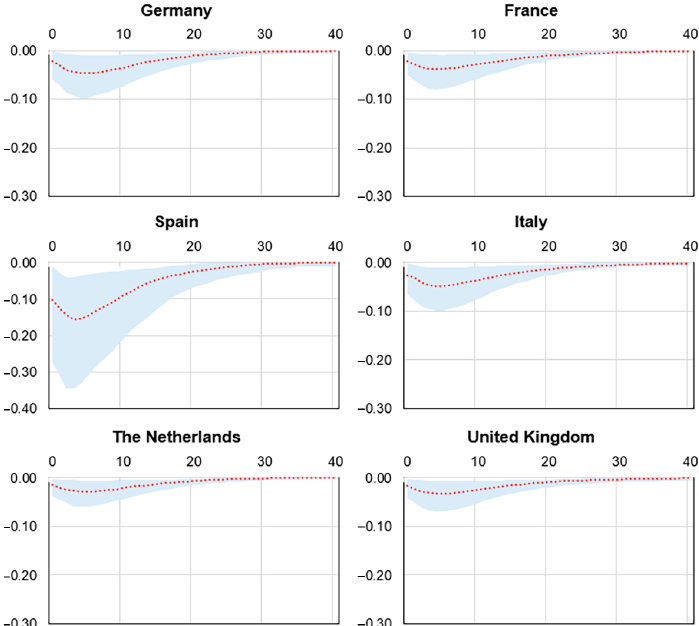
Figure 3. Impulse response functions of a one standard deviation supply shock in Euro Area on the selected developed European countries economic growth (source: authors’